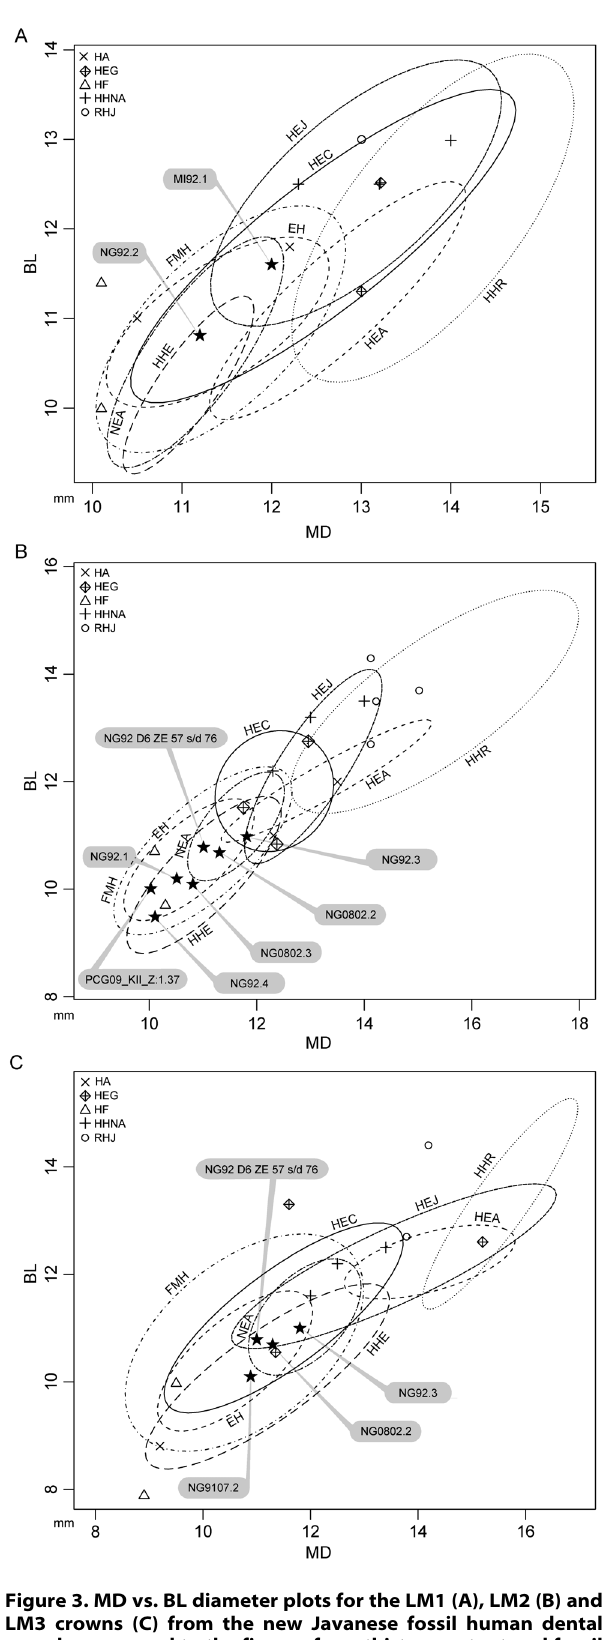
Figure 3. MD vs. BL diameter plots for the LM1 (A), LM2 (B) and LM3 crowns (C) from the new Javanese fossil human dental sample compared to the figures from thirteen extant and fossil human samples represented by 95% confident equiprobable ellipses. The specimens NG92.3, NG92.D6 ZE 57s/d 76 and NG0802.2